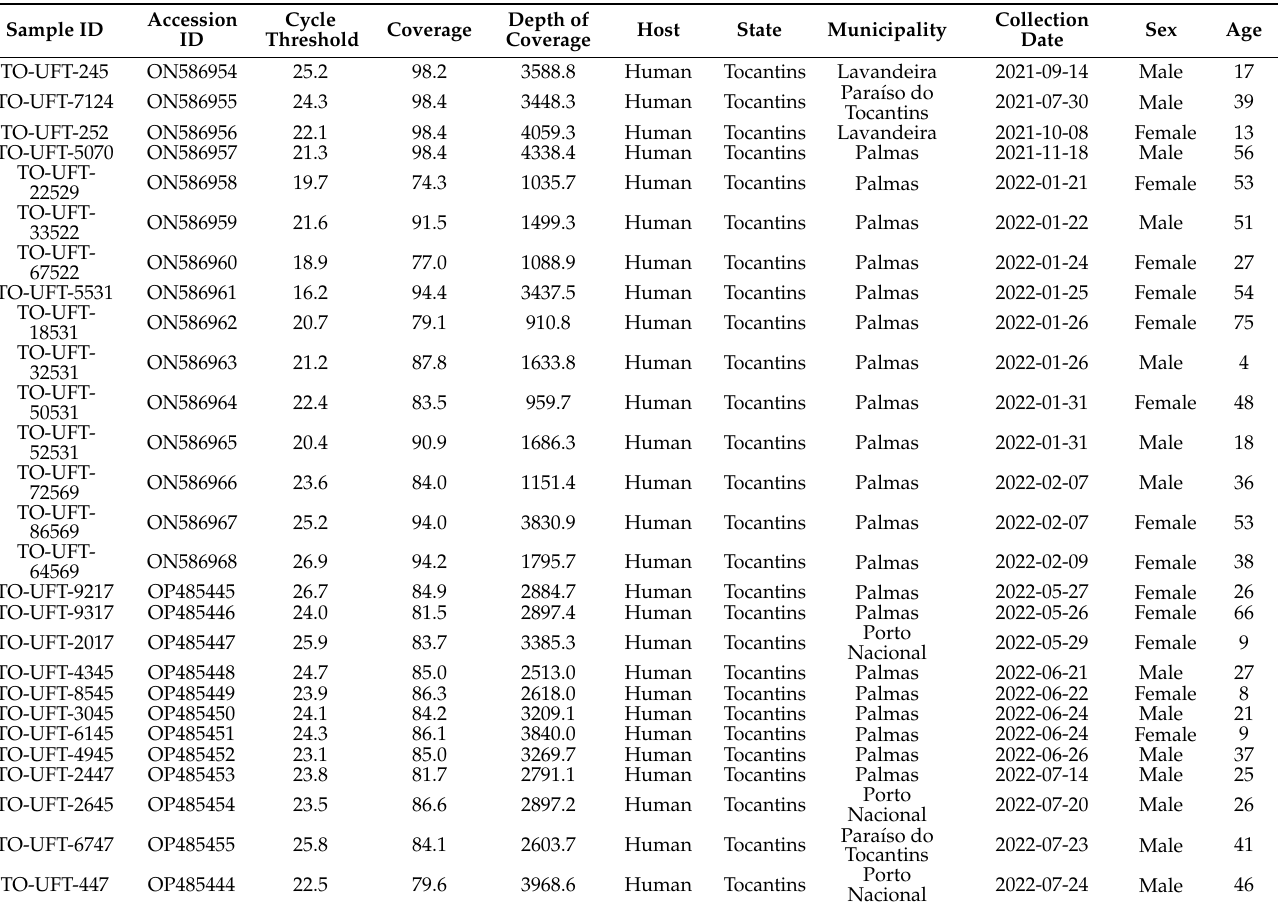
Table 1. Epidemiological data associated with sequenced samples were analyzed in this